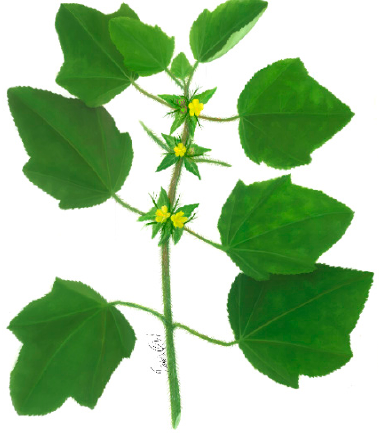
Figure 7. Malachra urens Poit.